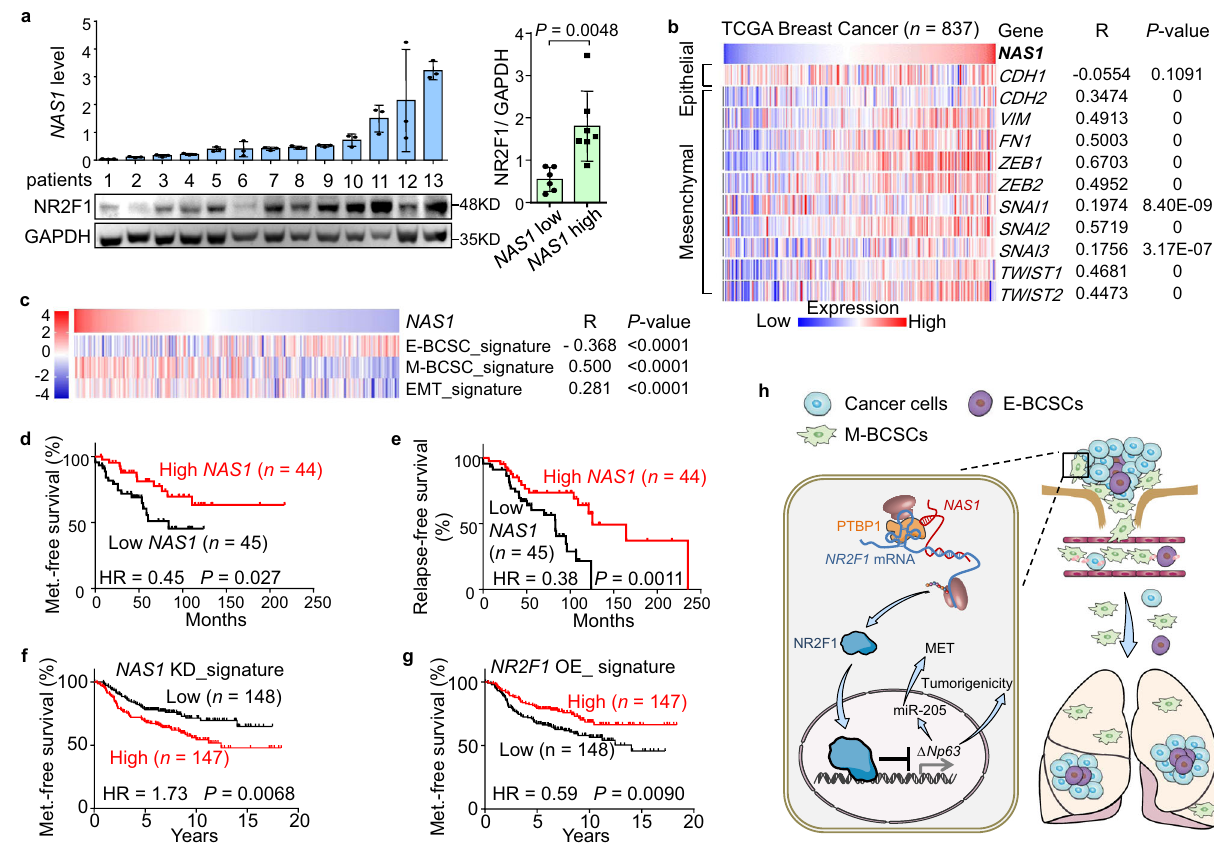
Fig. 7 The clinical relevance of NAS1 expression in human breast tumors. a Expression of NAS1 (upper left) and NR2F1 (lower left) in breast tumors from 13 patients, and quantitation of NR2F1 protein levels in tumors with high or low NAS1 expression (right) ( n = 13 patients). b Correlation analyses between NAS1 and EMT-related genes in 837 TCGA breast cancer samples. R, Pearson ’ s correlation coef fi cient of the genes to NAS1 . c Correlation between NAS1 expression and the ssGSEA scores of E-BCSC, M-BCSC, and EMT signatures in the Fudan cohort 47 ( n = 447 patients). d Metastasis-free survival analysis of the Qilu breast cancer cohort by NAS1 expression. HR hazard ratio. e Relapse-free survival analysis of the Qilu cohort by NAS1 expression. f , g Metastasis-free survival analyses of NKI cohort 75 ( n = 295 patients) by ssGSEA scores of gene sets regulated by NAS1 knockdown ( f ) or NR2F1 overexpression ( g ). h Schematic model of the mechanism by which NAS1 induces metastatic dormancy of breast cancer cells via NAS1 /NR2F1/ Δ Np63 axis. Data represent mean±SD ( a ). Statistical signi fi cance was determined by a two-tailed unpaired t test ( a ), paired t test ( b , c ), or two-sided log-rank test ( d – g Fig. 10g), supporting a role of NAS1 to suppress tumorigenicity.